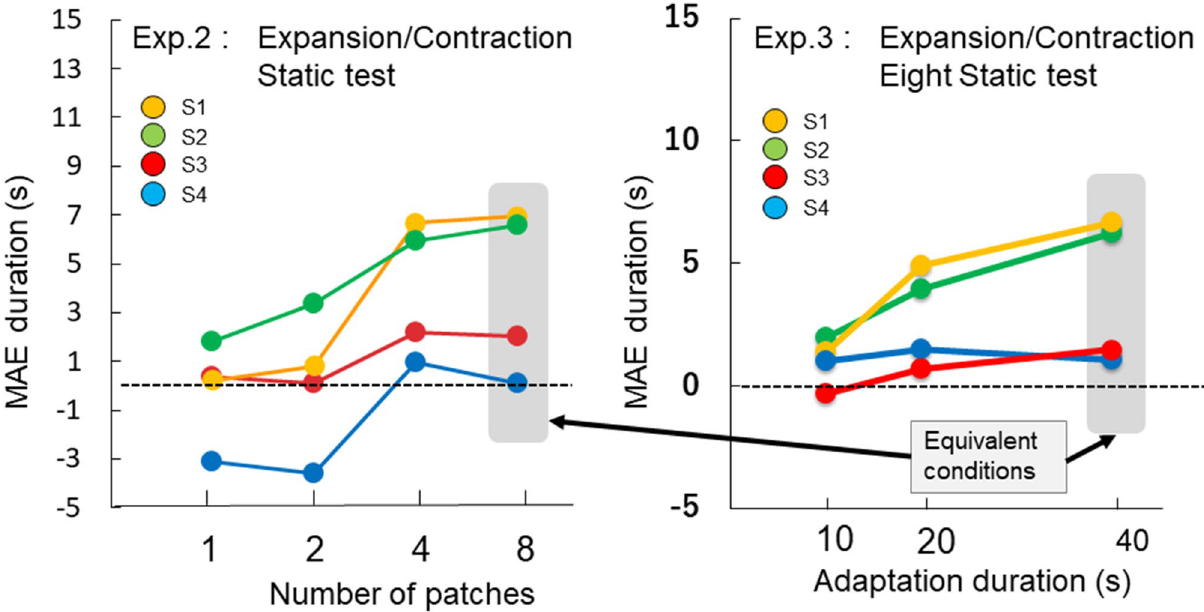
Figure 5. Results of individual participants of expansion/contraction in Experiment 2 (left) and in Experiment 3 (right). The 8-patch condition in Exp.2 and the 40 s condition in Exp. 3 are equivalent condition. The same four participants took part in the expansion/contraction conditions in both Exps 2 and